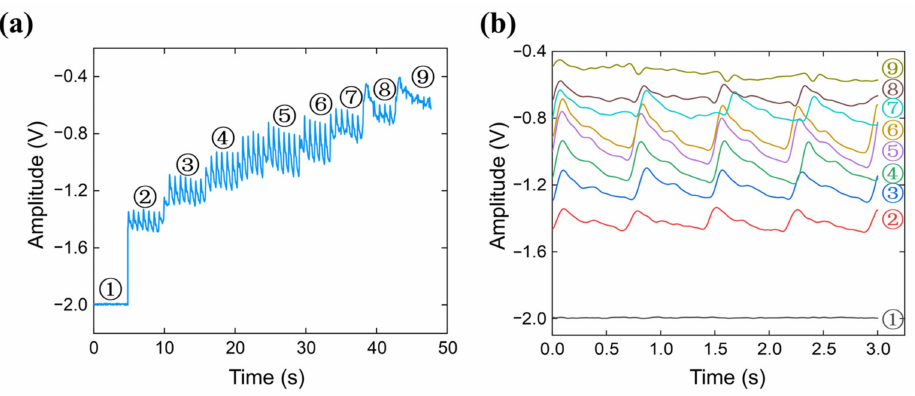
Figure 7. Pulse waves under increasing applied pressures. ( a ) The collected pulse signals. ( b ) The detailed pulse